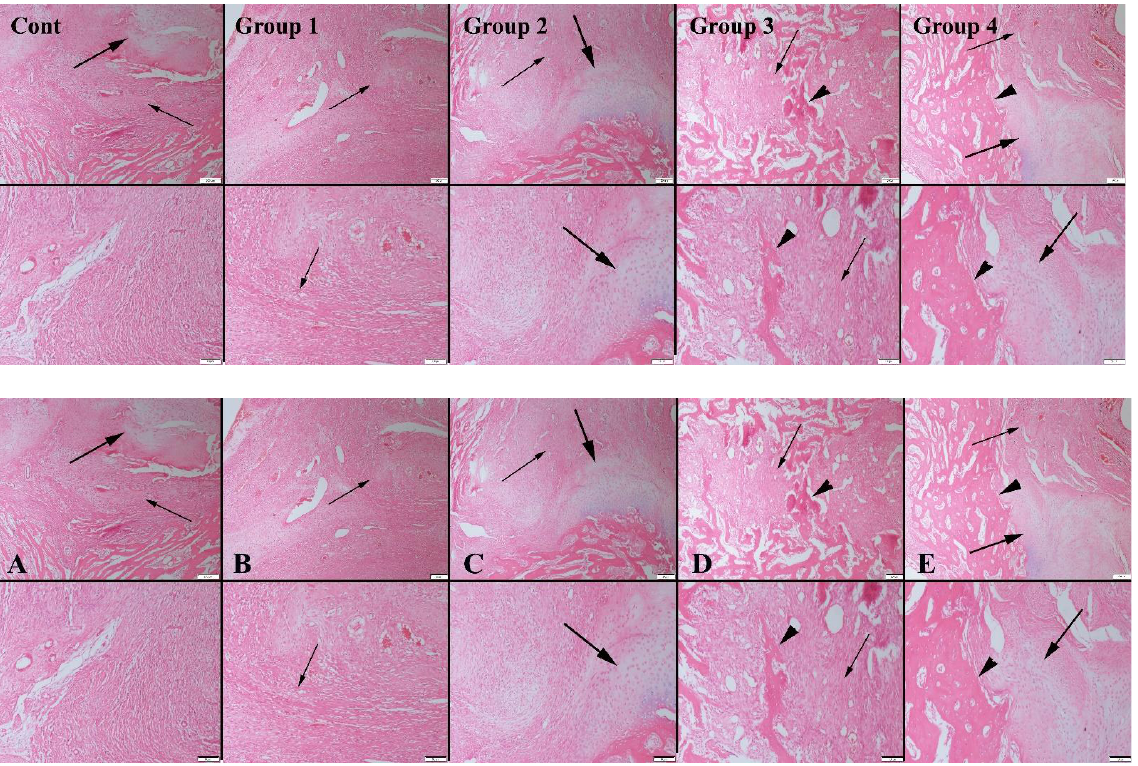
Figure 7. Representative histopathological micrographs of bone fracture areas. A) Control group, B) Group 1, C) Group 2, D) Group 3 and E) Group 4, lower row higher magnification, Fibrous tissue (thin arrows), cartilage (thick arrows) and new bone tissues (arrow heads) (upper row) at 8-week groups, higher magnification (lower row), HE, scale bars = 200 µm (for upper row) and 100 µm (for lower row).